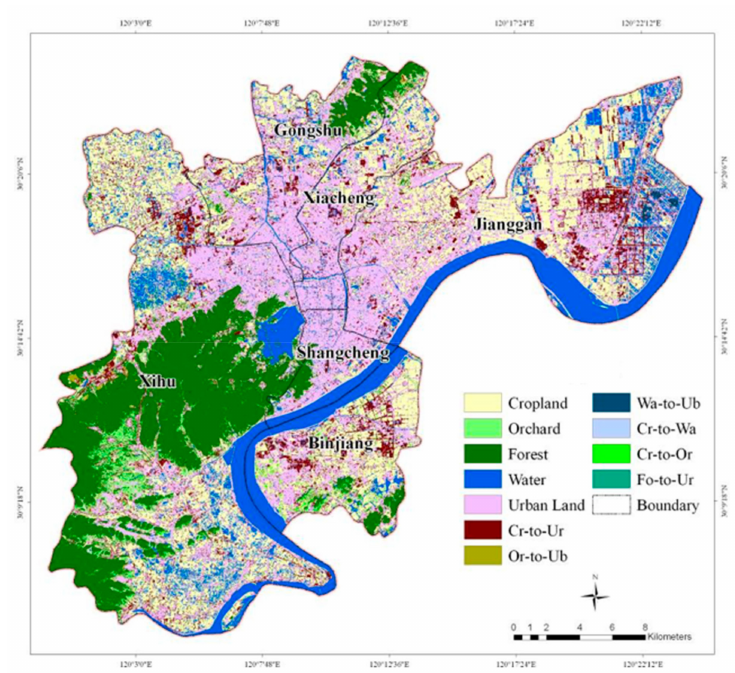
Figure 9. Result of land use and land use changes, 2000–2003.